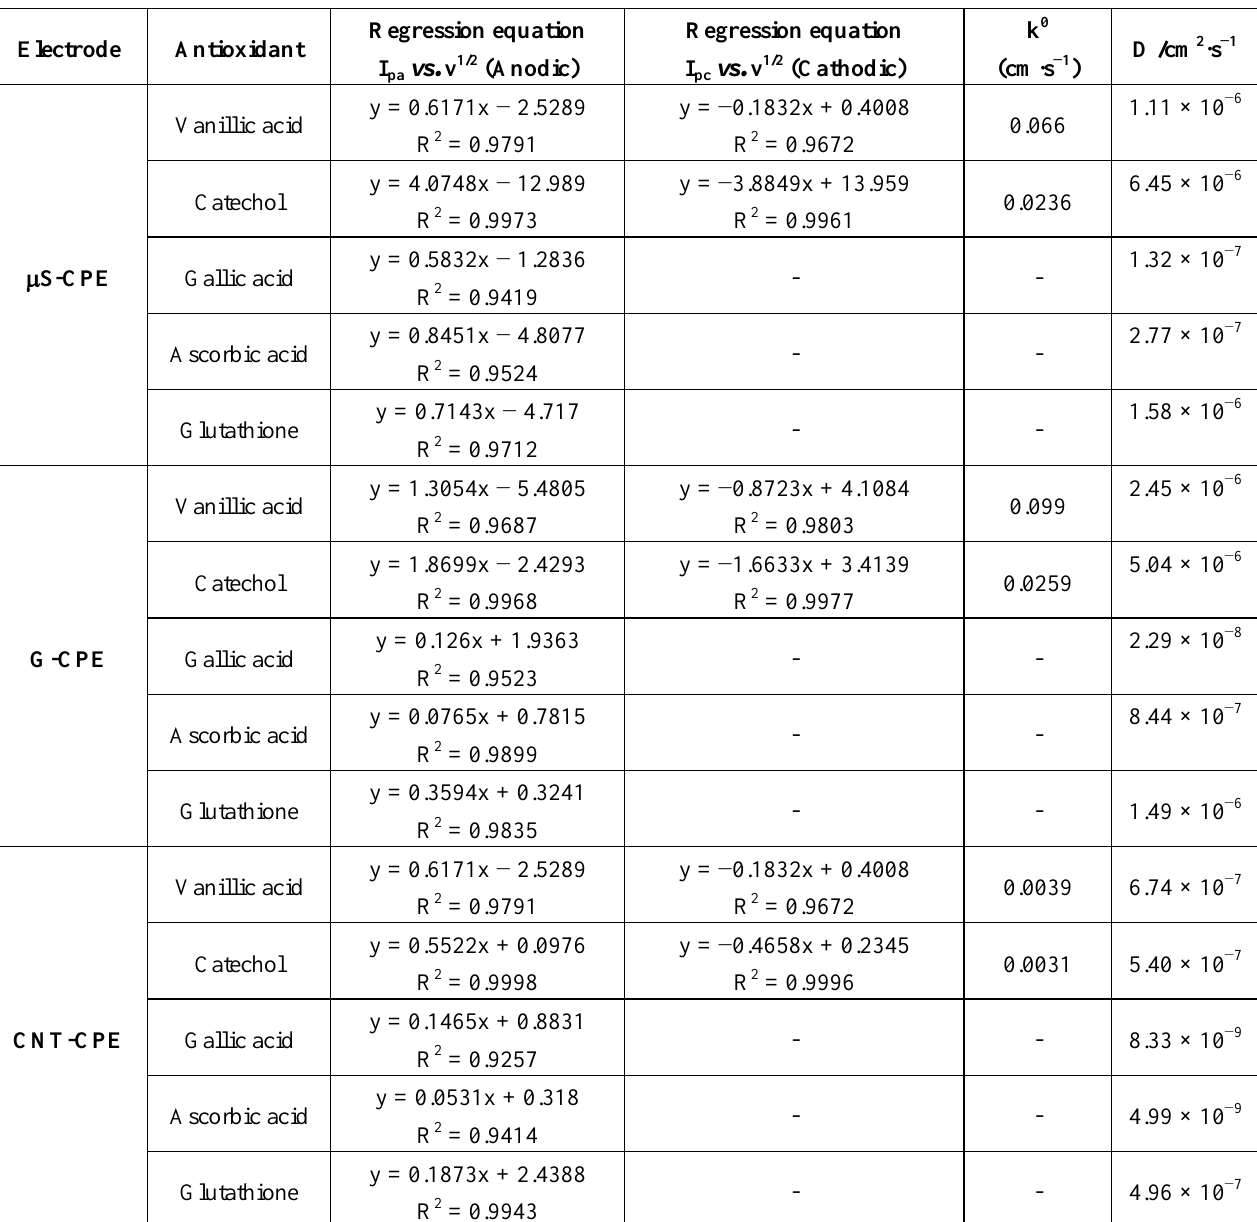
Table 2. The results obtained in the kinetic studies for all CPEs in antioxidant solution.